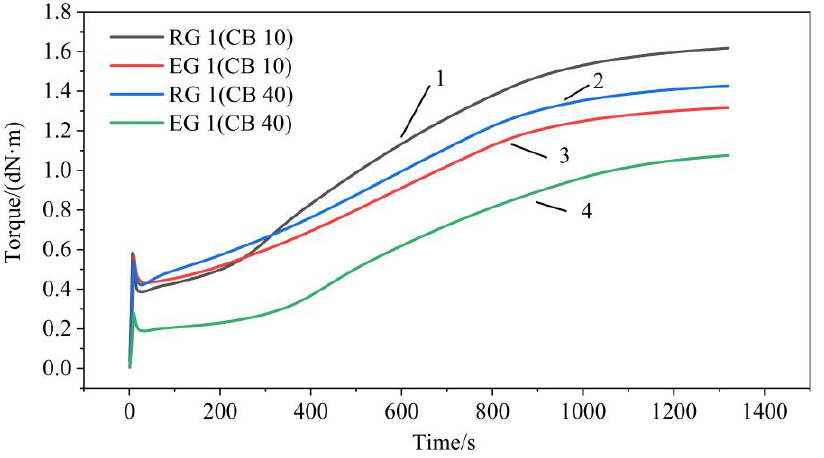
Figure 2. Curing characteristics of rubber compounds with different curing systems. Line 1 was for RG 1 with CB of 10 phr; Line 2 was for EG 1 with CB of 10 phr; Line 3 was for RG 1 with CB of 40 phr; Line 4 was for EG 1with CB of 40